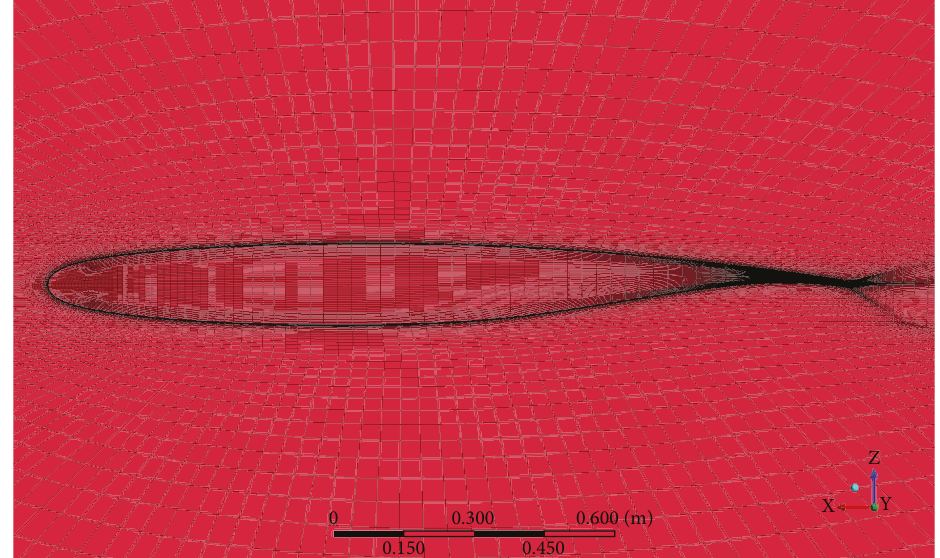
Figure 6: Side view of curved-wing domain